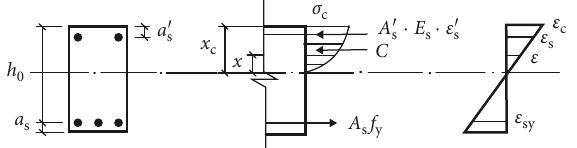
Figure 2: Force diagram of the beam